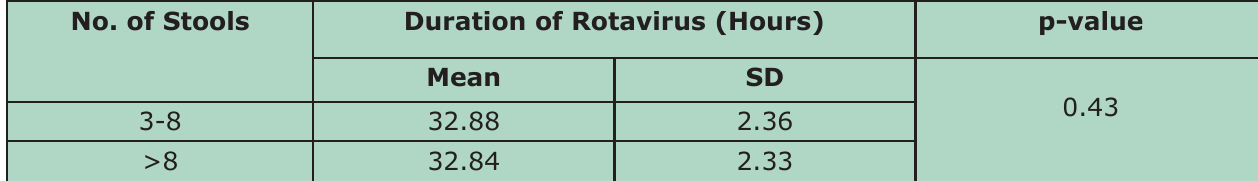
Table-III: Stratification for Mean Duration of Rotavirus Diarrhea in Children After Administration of First Dose of Nitazoxanide with Regards to no. of Stools